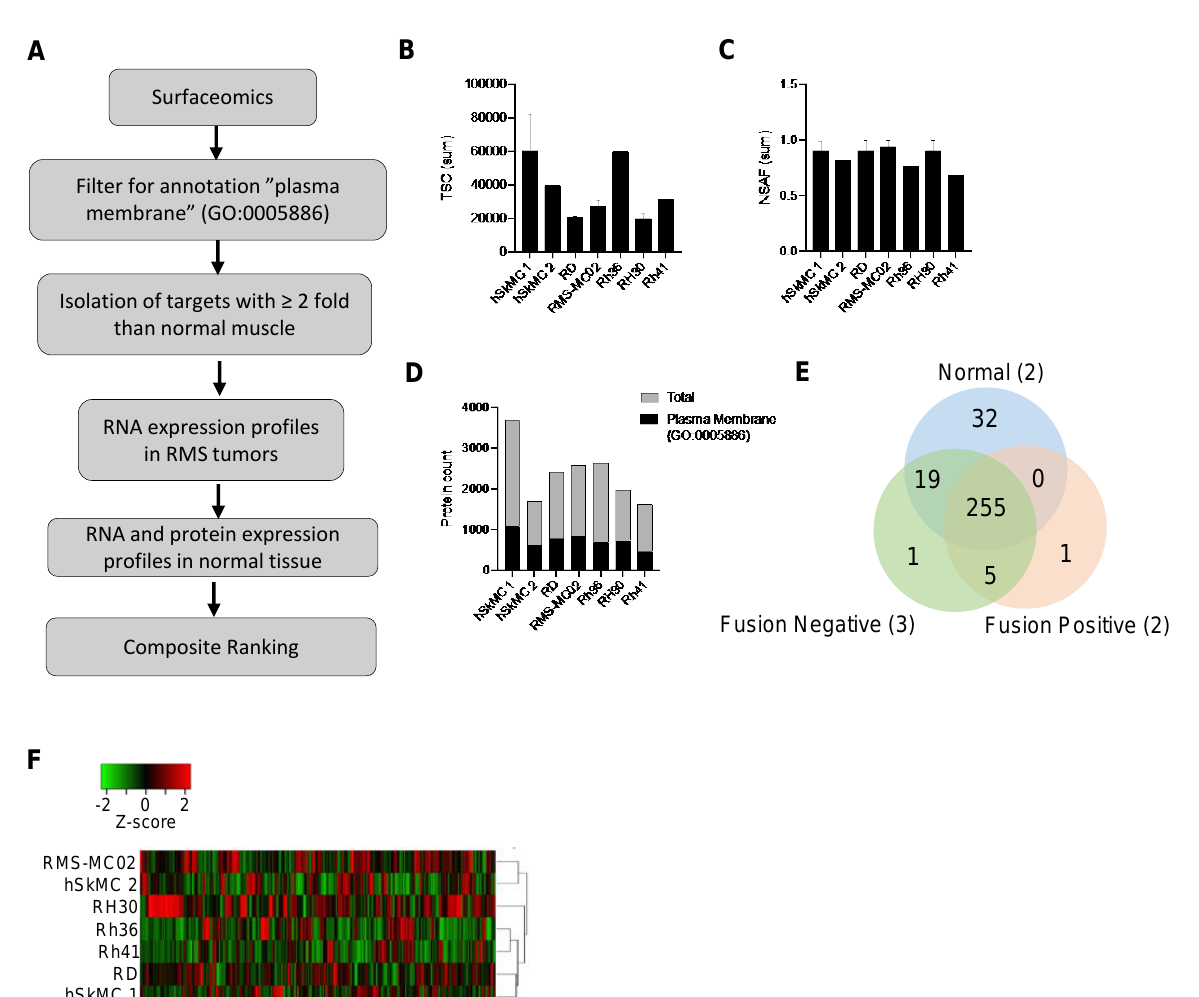
Figure 1. Distinct cell-surface protein signatures are identified in RMS subtypes and normal muscle